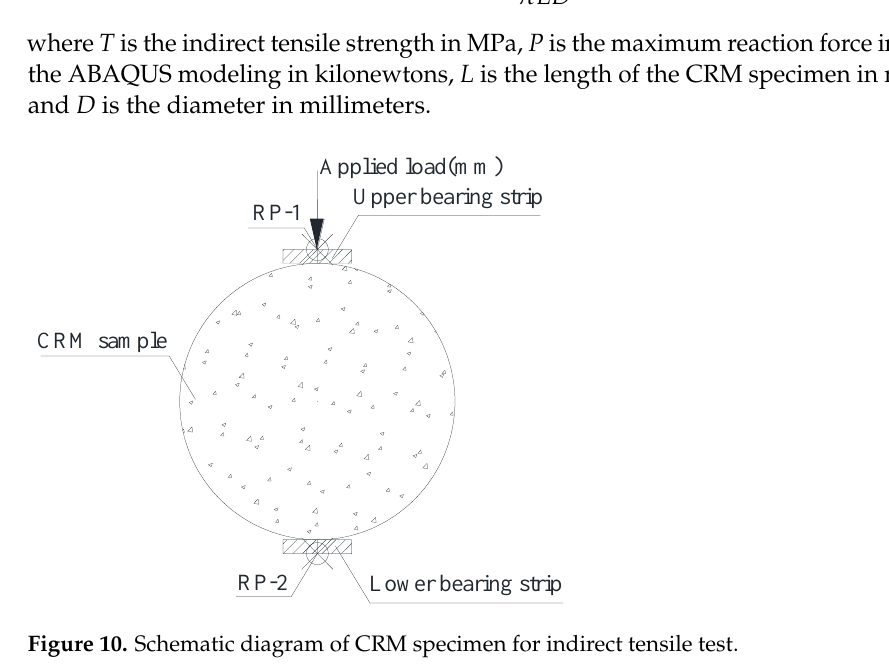
Figure 10. Schematic diagram of CRM specimen for indirect tensile test.